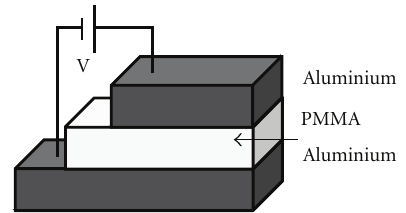
Figure 1: Schematic diagram of the memory